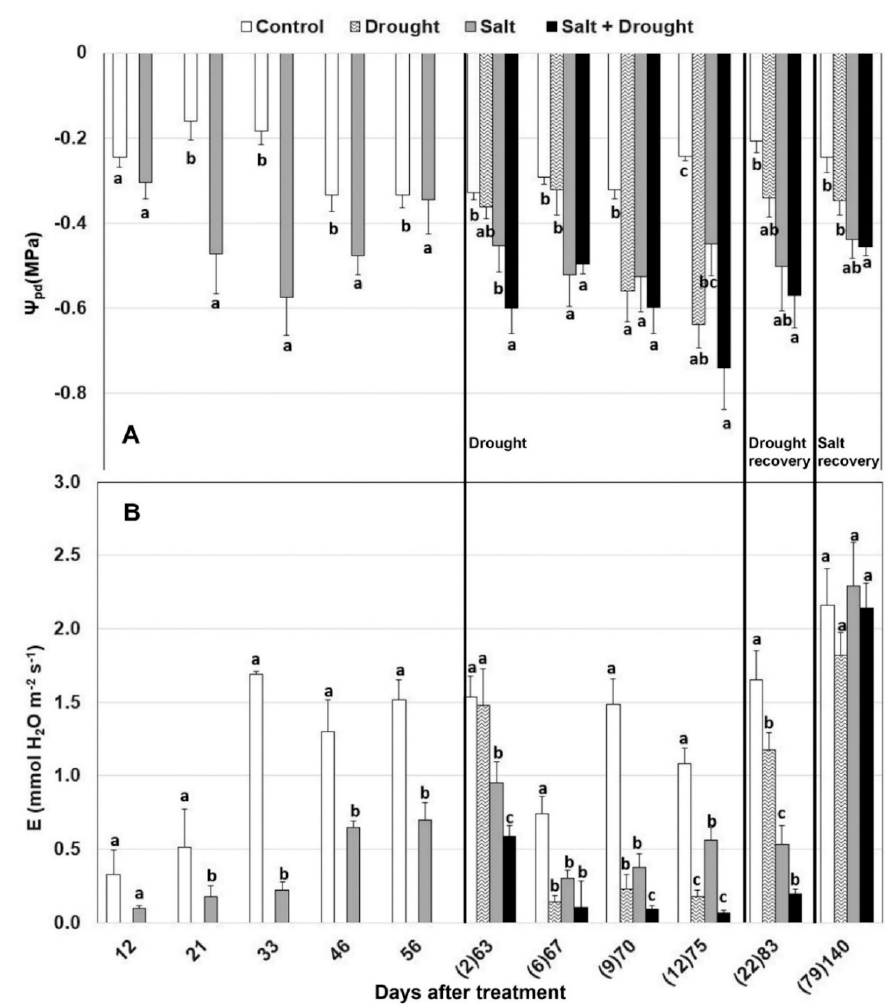
Figure 2. Effect of drought, salt, and the combination of both stresses, on ( A ) predawn water potential ( ψ pd ) and ( B ) transpiration rate. The days after drought treatment are reported in brackets. Values per treatments are mean ± SE ( n = 10). Data characterized by the same letter do not differ significantly ( p < 0.05, Tukey’s HSD test).